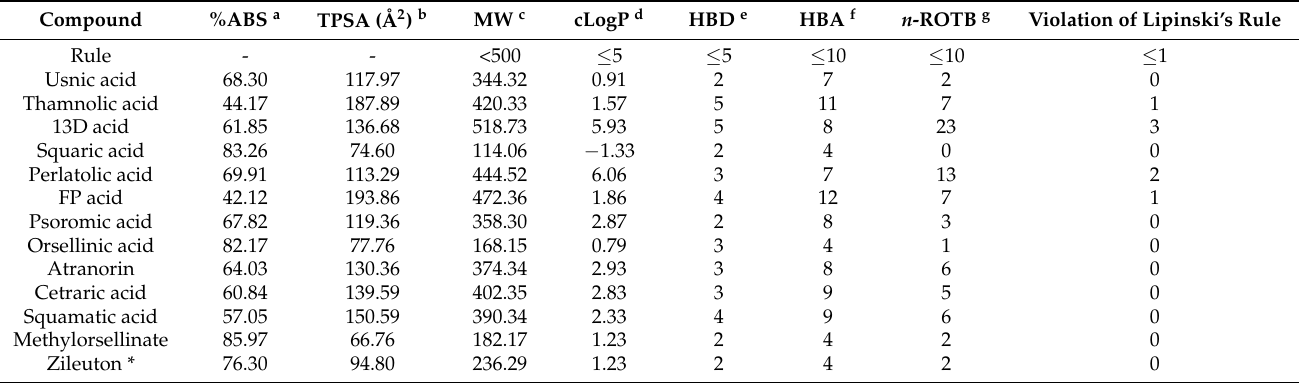
Table 4. Pharmacokinetic properties of compounds present in the species of the genus Cladonia in comparison with the commercial 5-LOX redox inhibitor (Zileuton) obtained from Osiris Data Warrior and Molinspiration software (v 5.5.0).